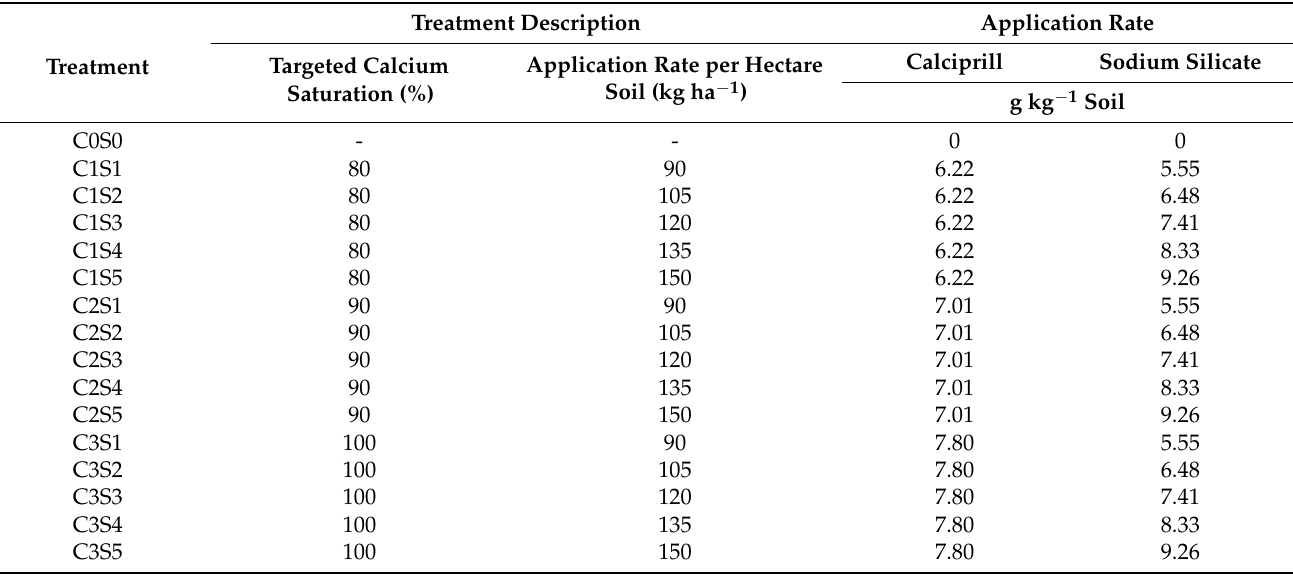
Table 2. Details of the application rates of Calciprill and sodium silicate treatments for the soil leaching